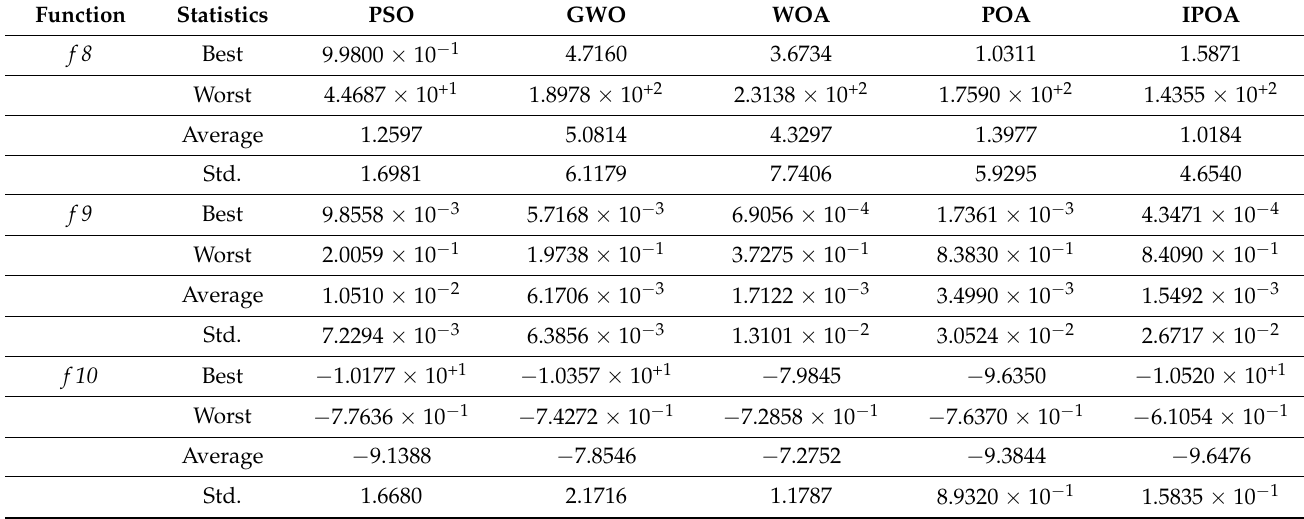
Table 5. Statistical results for composite benchmark functions.